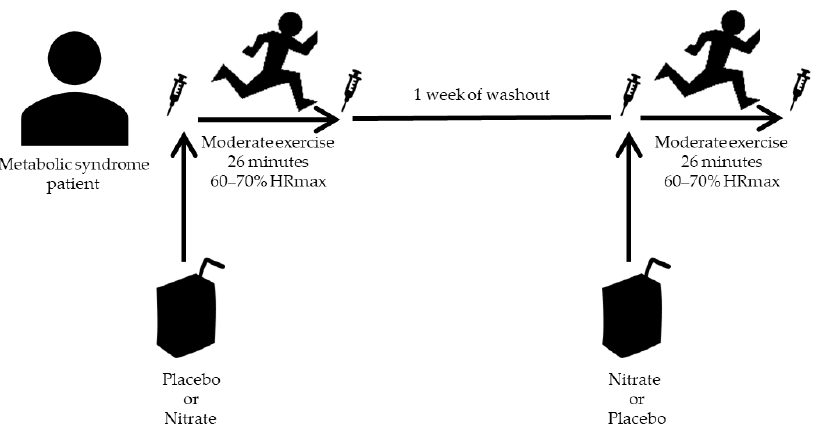
Figure 1. Schematic design of the randomized, double-blind, 2 × 2 crossover study. Participants that took the placebo beverage in the first experience took the nitrate-rich beverage in the second one, and vice versa.